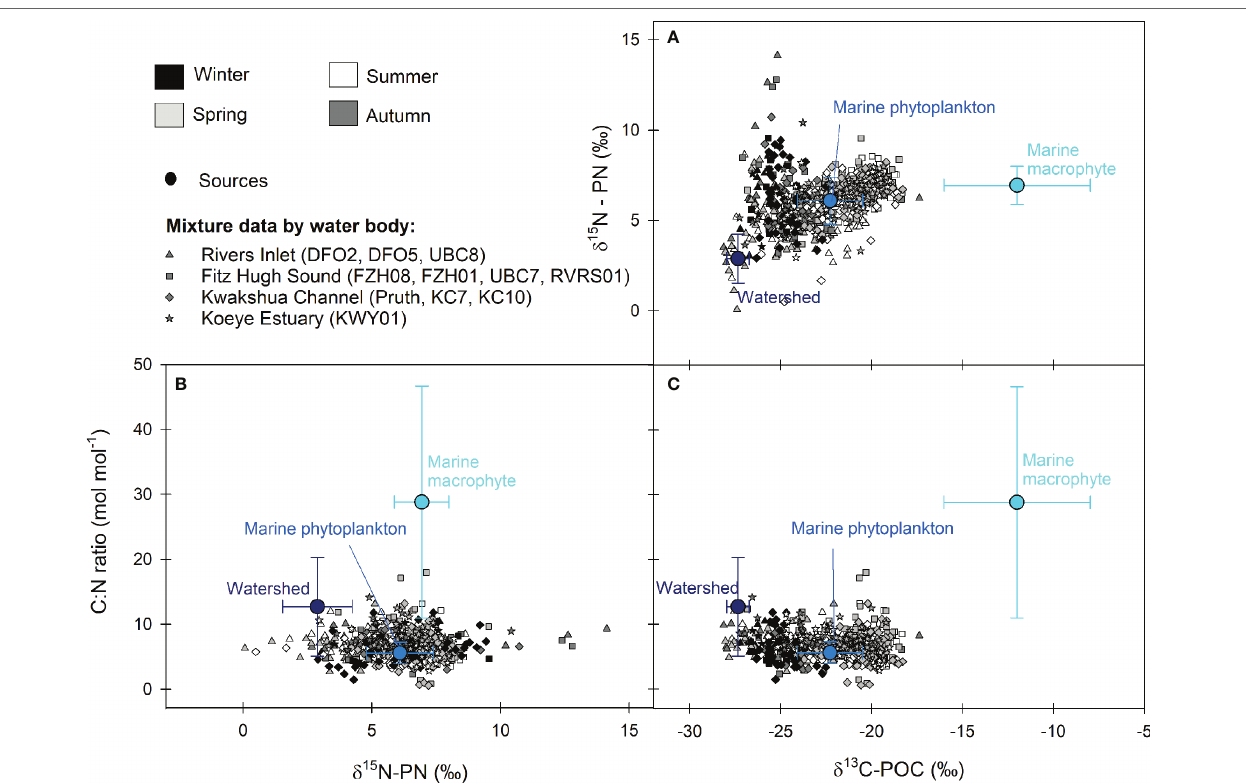
FIGURE 3 | Isospace plots showing all mixture data by season (greyscale) and main water body (shape) and the mean ± SD for the three end-members in (A) δ 13 C- POC – δ 15 N-PN, (B) δ 15 N-PN – C:N molar ratio, and (C) δ 13 C-POC – C:N molar ratio space. Rivers Inlet (triangles) includes stations UBC8, DFO5 and DFO2. Fitz Hugh Sound (squares) includes stations RVRS01, UBC7, FZH01 and FZH08. Kwakshua Channel (diamonds) includes stations Pruth, KC7 and KC10 and the Koeye Estuary (stars) is station